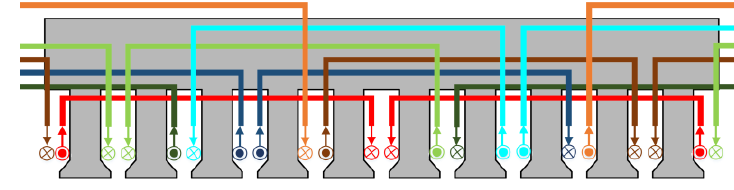
Figure 3. Winding pattern for N p = 6, N s = 28 ( q = 2 / 3 ).